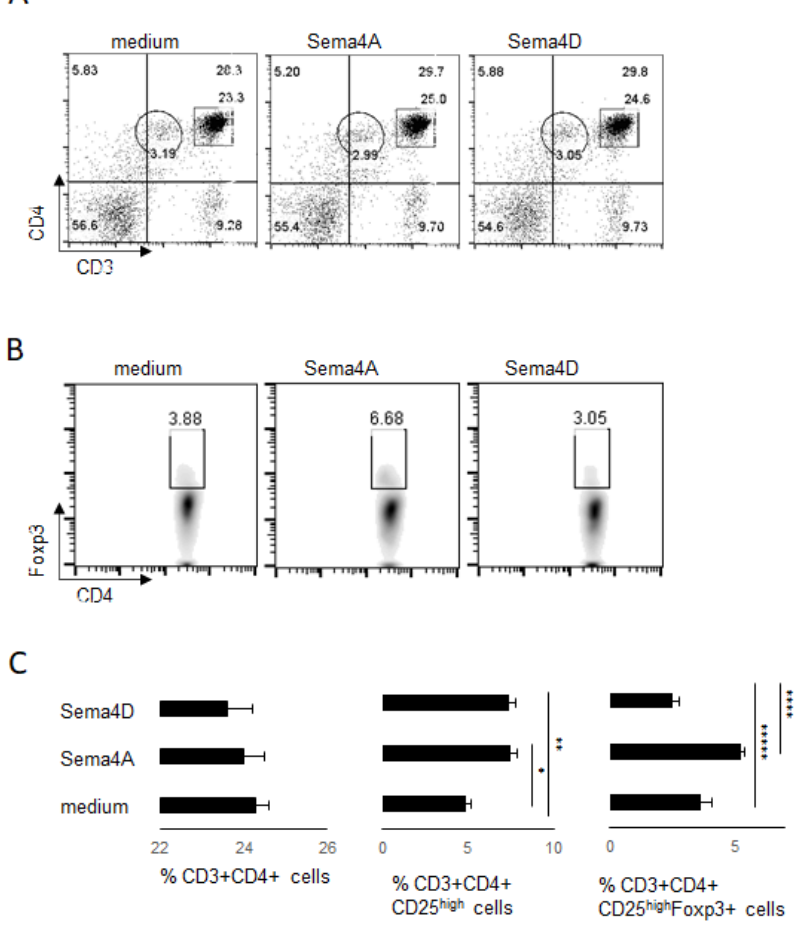
Figure 1. Human Sema4 proteins affect Treg cells in PBMC cultures. Human PBMC were cultured with or without 100 ng of external rhSema4A or rhSema4D for 48 h. After harvest, the numbers of CD4+ T cells (panels ( A , C )) and Treg cells (panels ( B , C )) were assessed by flow cytometry, using specific Abs to corresponding cell surface and intracellular molecules. CD3+CD4+ cells shown on upper panel dot plots ( A ) were further selected to evaluate the relative number of Treg cells ( B ) in each in vitro experimental setting. The Treg cells were gated on CD4+Foxp3+ density plots. ( C ) The graphical representation of data with corresponding statistics. * p < 0.013, cultures with medium vs. rhSema4A, ** p < 0.012, medium vs. rhSema4D, *** p = 0.012, medium vs. rhSema4A, **** p = 0.001, rhSema4A vs. rhSema4D, ***** p = 0.040, medium vs. rhSema4D. Data are representative from three independent experiments.